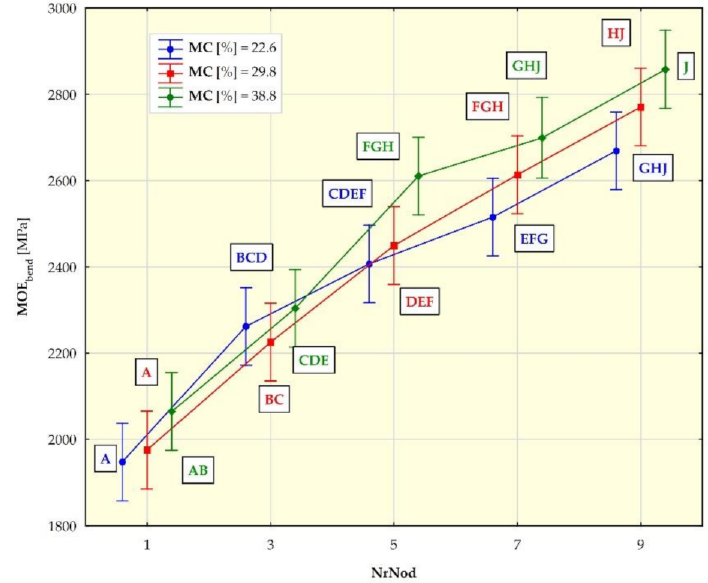
Figure 9. Average modulus of elasticity in bending (MOE bend ) values for different internodes (NrNod) and moisture content (MC). All data are expressed as mean ± 95% confidence interval (the latter being represented by whiskers in the diagram). Different letters indicate significant differences between the groups according to Tukey’s test ( p < 0.05). Homogeneous groups are marked with the same letters.